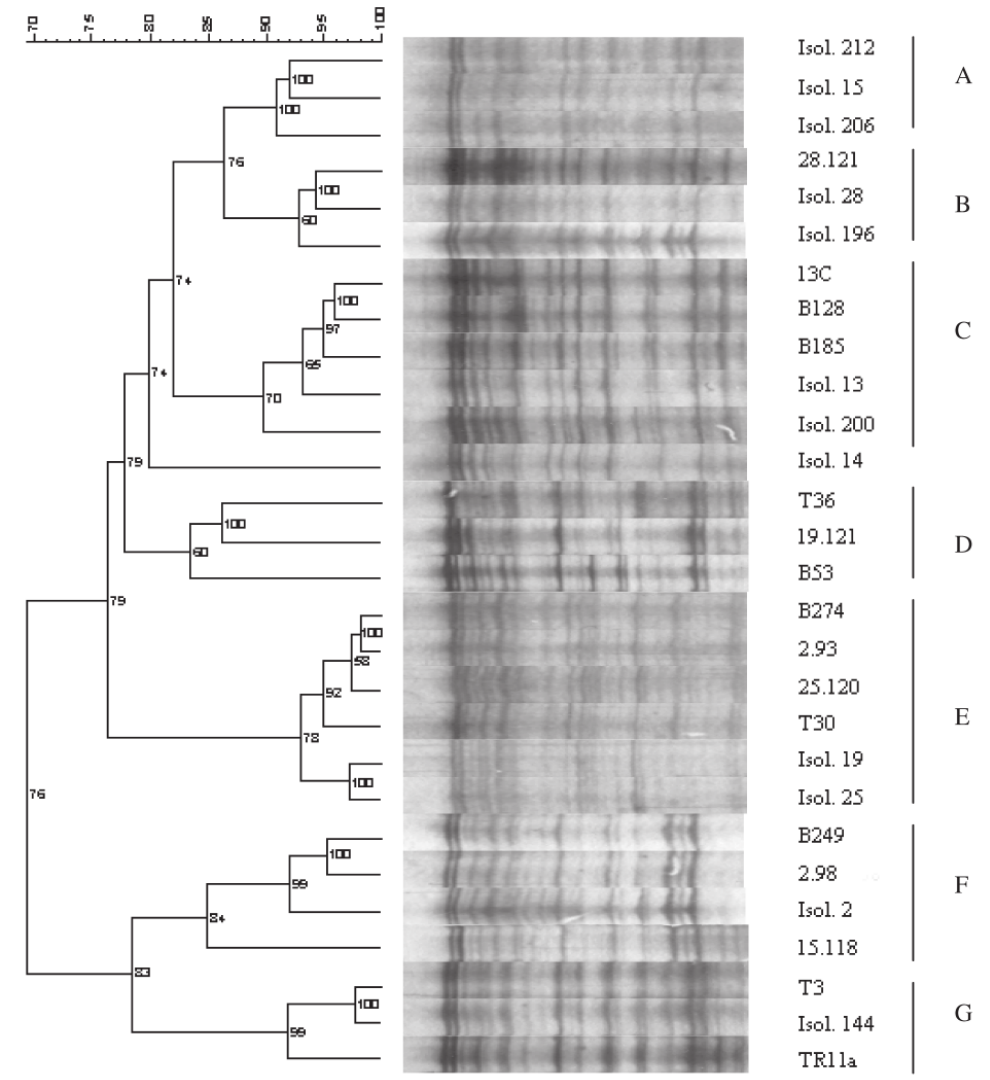
Fig. 1. Dendrogram and respective CFLP patterns of the 12 isolates and 16 cloned standards. Major clusters are indicated on the right (A, B, C, D, E, F and G). The rule-bar at the top-left represents the similarity (%) between patterns. Numbers in the dendrogram refer to the cophenetic correlation values. Isolates 19 and 25 were the only ones that did not induce stem pitting in sweet orange (SP-SwO) or grapefruit, nor quick decline, thus being consid- ered mild